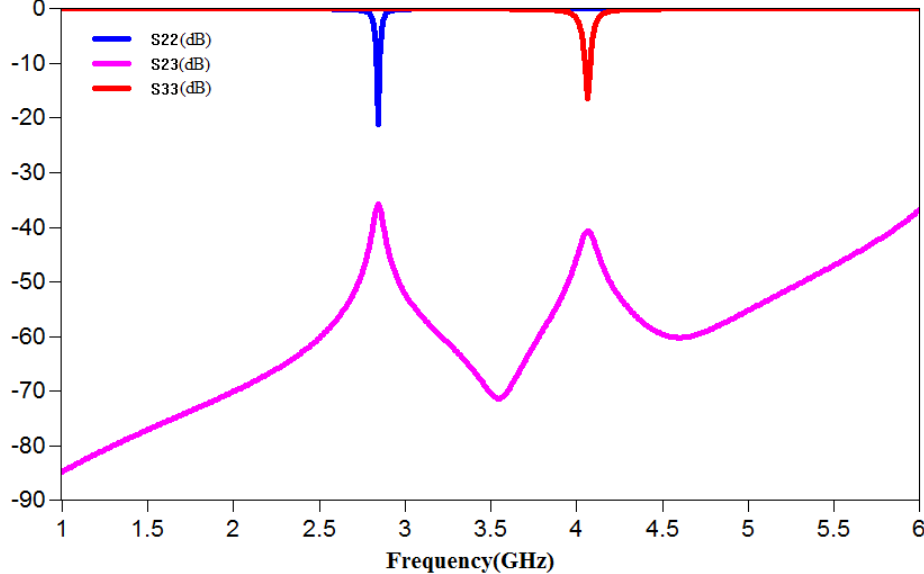
Figure 8. Simulated S22 , S33 , and S23 scattering responses for the projected diplexer based on the Kappa substrate.